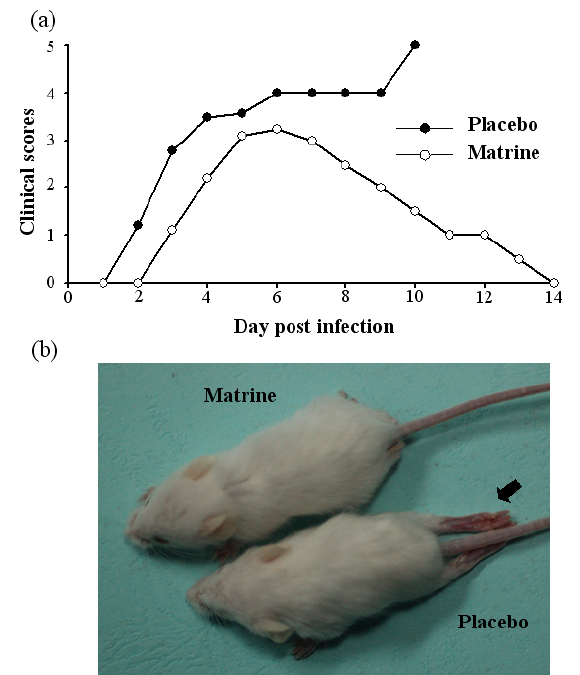
Figure 4. ( a ) The clinical scores of the infected mice treated with placebo or matrine (20 mg/kg) was systematically evaluated in independent experiments (n = 30). ( b ) The typical phenotype of ruffled hair and paralysis of hind limbs caused by EV71 infection at 7 dpi (indicated by arrow) was shown, and the symptoms were prevented in the matrine-treatment group.